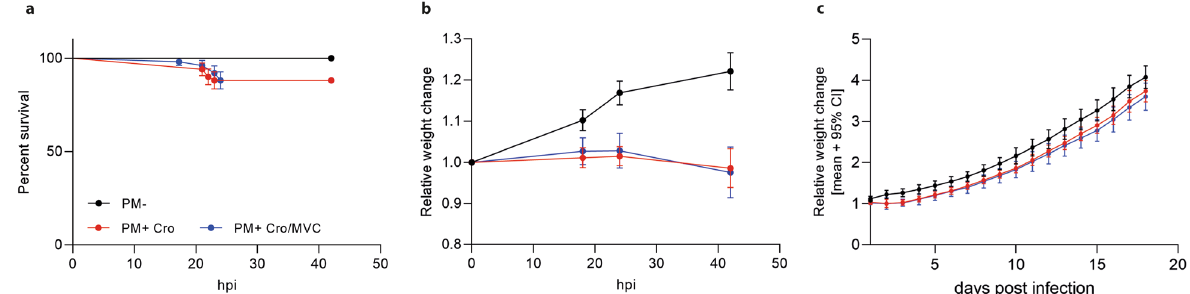
Figure 2. Survival and weight change in rats with PM. ( a ) Infected animals showed reduced survival compared to mock-infected ones independent of treatment modalities. Weight change during acute PM ( b ) and long-